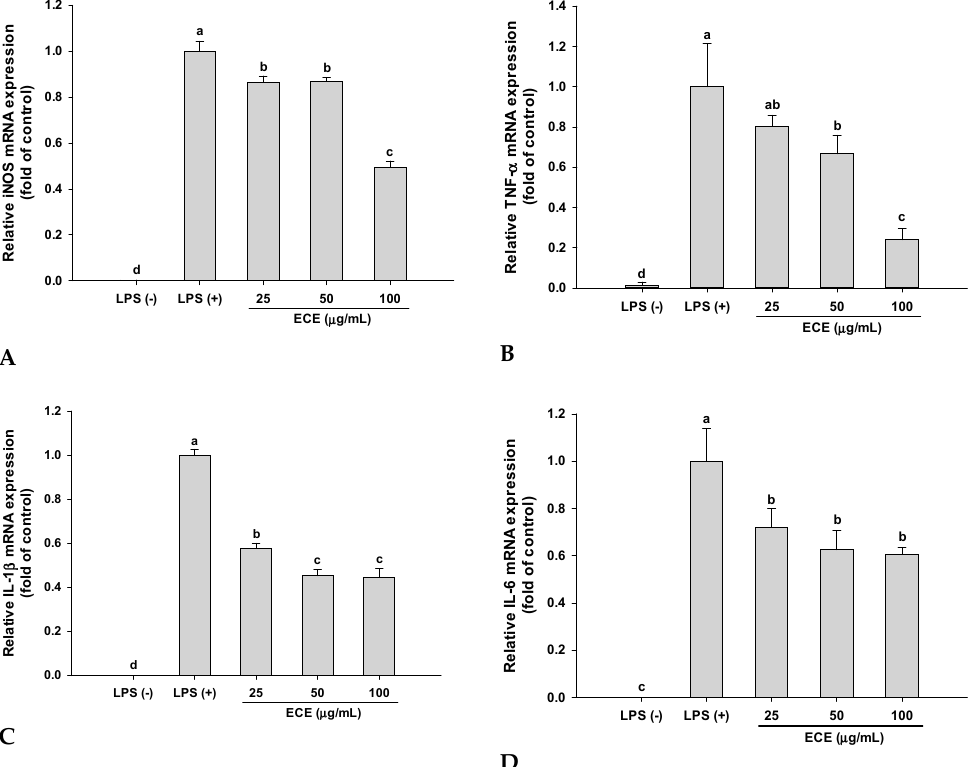
Figure 2. Effect of ECE on (A) iNOS, (B) TNF- α , (C) IL-1 β , and (D) IL-6 expressions in P. gingivalis LPS-stimulated RAW 264.7 macrophages. Cells were treated for 3 h in the presence of P. gingivalis LPS (5 μ g/mL) and samples. The expression levels of genes were analyzed using qPCR and normalized to that of β -actin. Data are presented as mean ± SD and bars with different letters indicate significant differences at p < 0.05. ECE: Ecklonia cava extract, LPS: lipopolysaccharide, iNOS: inducible nitric oxide synthetase, TNF- α : tumor necrosis factor alpha, IL-1 β : interleukin-1 β , IL-6: interleukin-6.